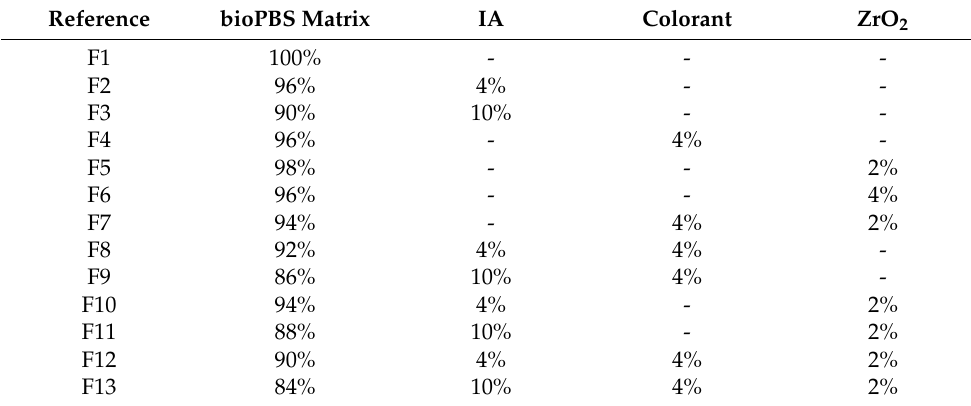
Table 1. Summary of material formulations based on bioPBS FZ71PD